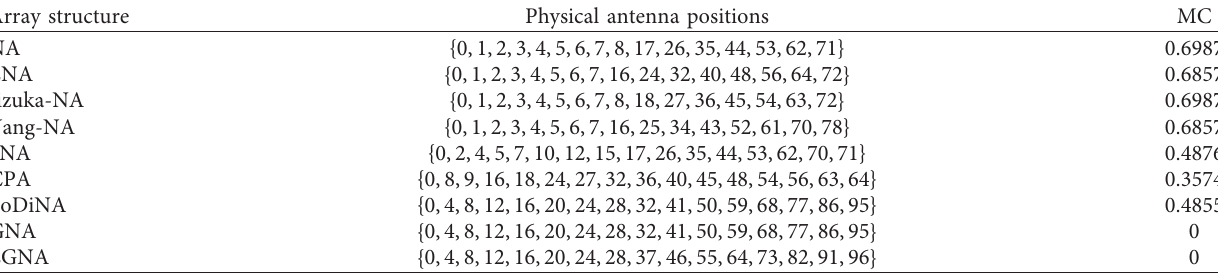
Table 3: Comparison of MC for different geometries.